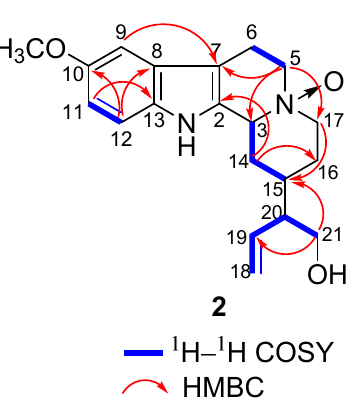
Figure 5. Key 1 H − 1 H COSY and HMBC correlations of 2 .